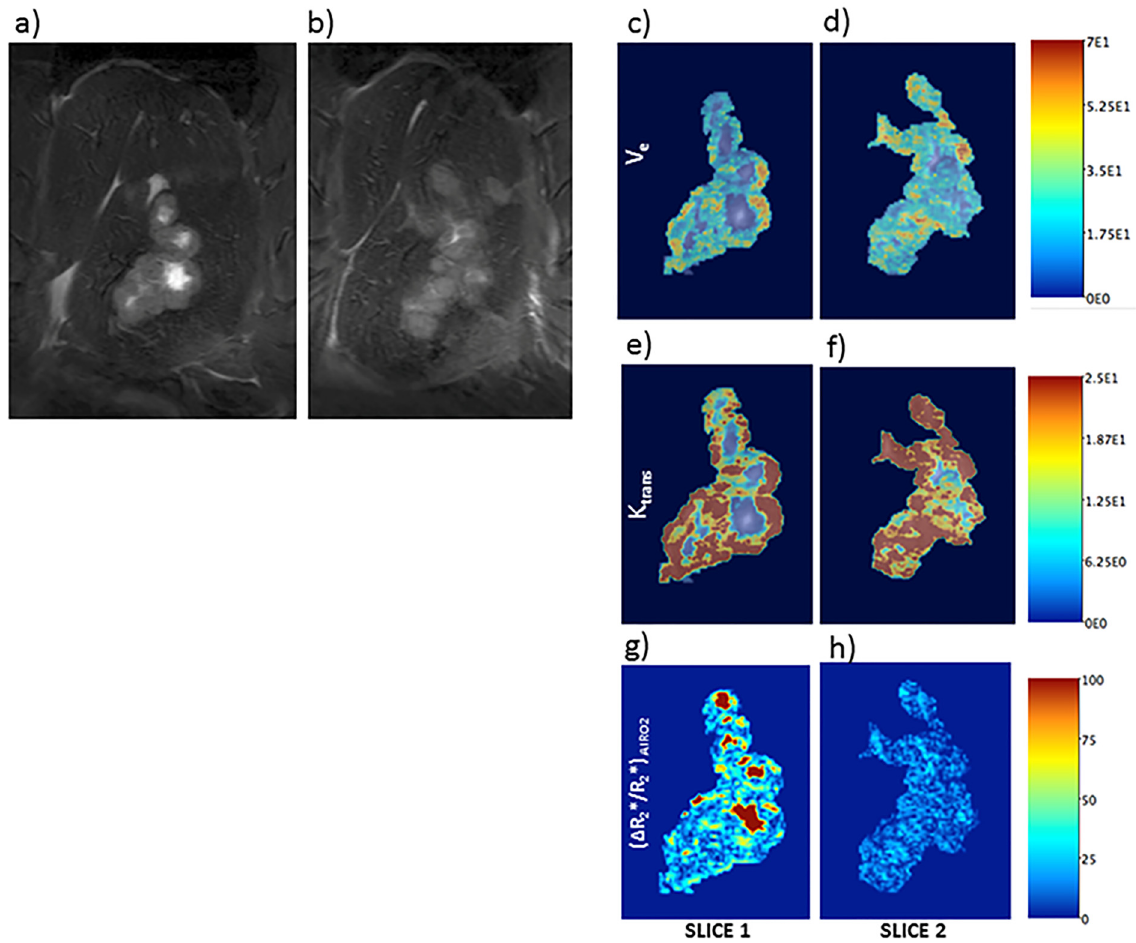
Fig 5. Quantitative MRI. Shown in (a) and (b) are two adjacent coronal slices of a representative rat liver with advanced stage tumor. Tumor lobes are identifiable as hyperintense relative to adjacent normal liver tissue within T2-weighted anatomic images. Shown In panels (c) – (h) are the corresponding parametric maps produced from dynamic contrast enhanced (DCE) image series. (f) These depict the vascular volume and permeability of tissues within the tumor region. R2 * difference map from gas-challenge BOLD MR studies in this tumor model are shown in panel; significant heterogeneity in both gas-challenge signal changes and quantitative DCE measurements suggest a heterogeneous tumor microenvironment with regional variations in perfusion, tissue oxygenation and blood